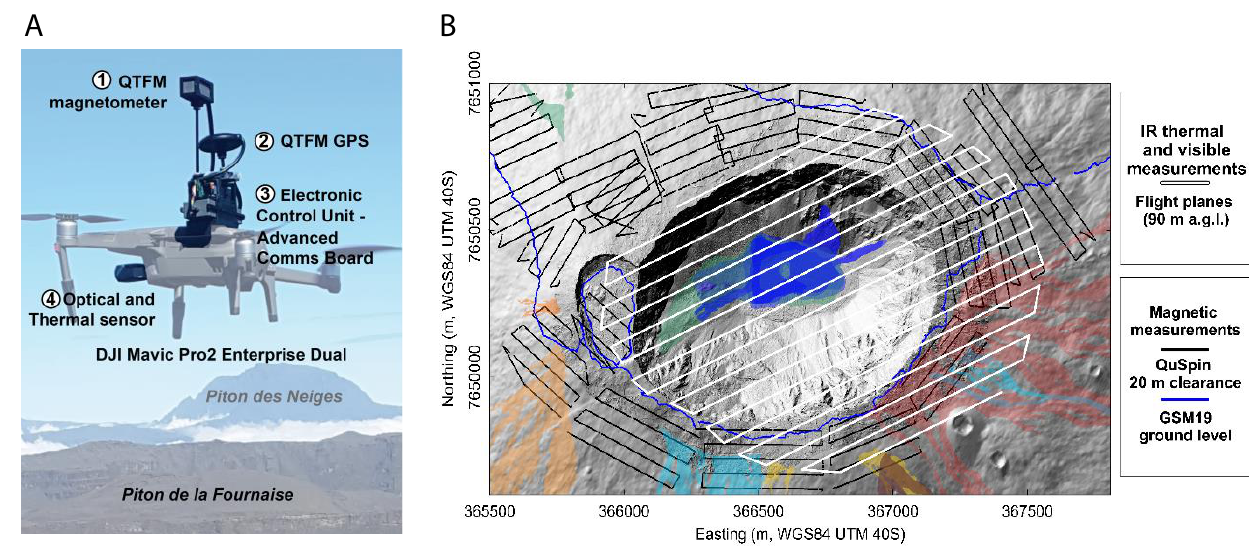
Figure 2: The 2020 geophysical survey. [A] QuSpin Total Field (QTFM) magnetic sensor, mounted on a DJI Mavic Pro2 Enterprise Dual with optical and thermal sensors. [B] Location of the UAV thermal IR (white) and magnetic measurement (black) profiles, superimposed onto the lava flows emitted close to the summit shown in Figure 1c.